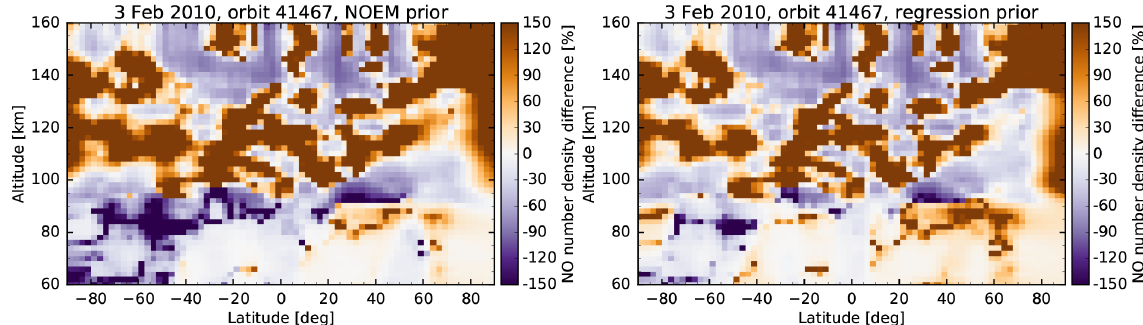
Figure 5. Relative NO number density differences from the SCIAMACHY MLT mode limb scans restricted to 50–91km using the NOEM model (right) and the regression model (left) as a priori input compared to the full retrieval (sample orbit no. 41467, 3 February